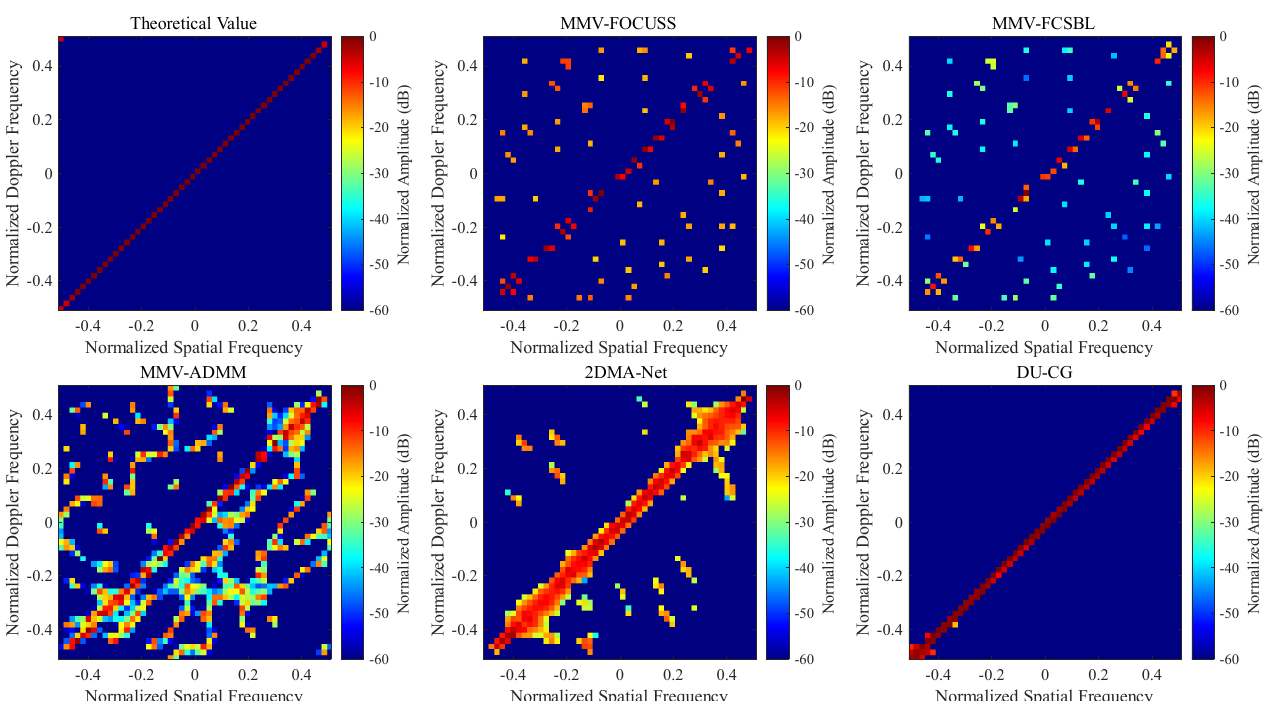
Figure 12. Clutter spectrum estimation results obtained using different methods in the non-ideal case with the element amplitude/phase error as 0.14/3.83°.